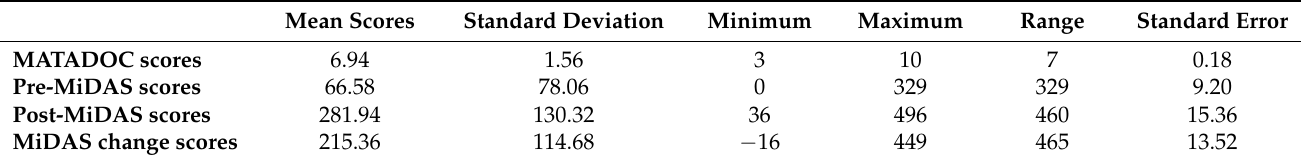
Table 3. Summary statistics of MATADOC and MiDAS